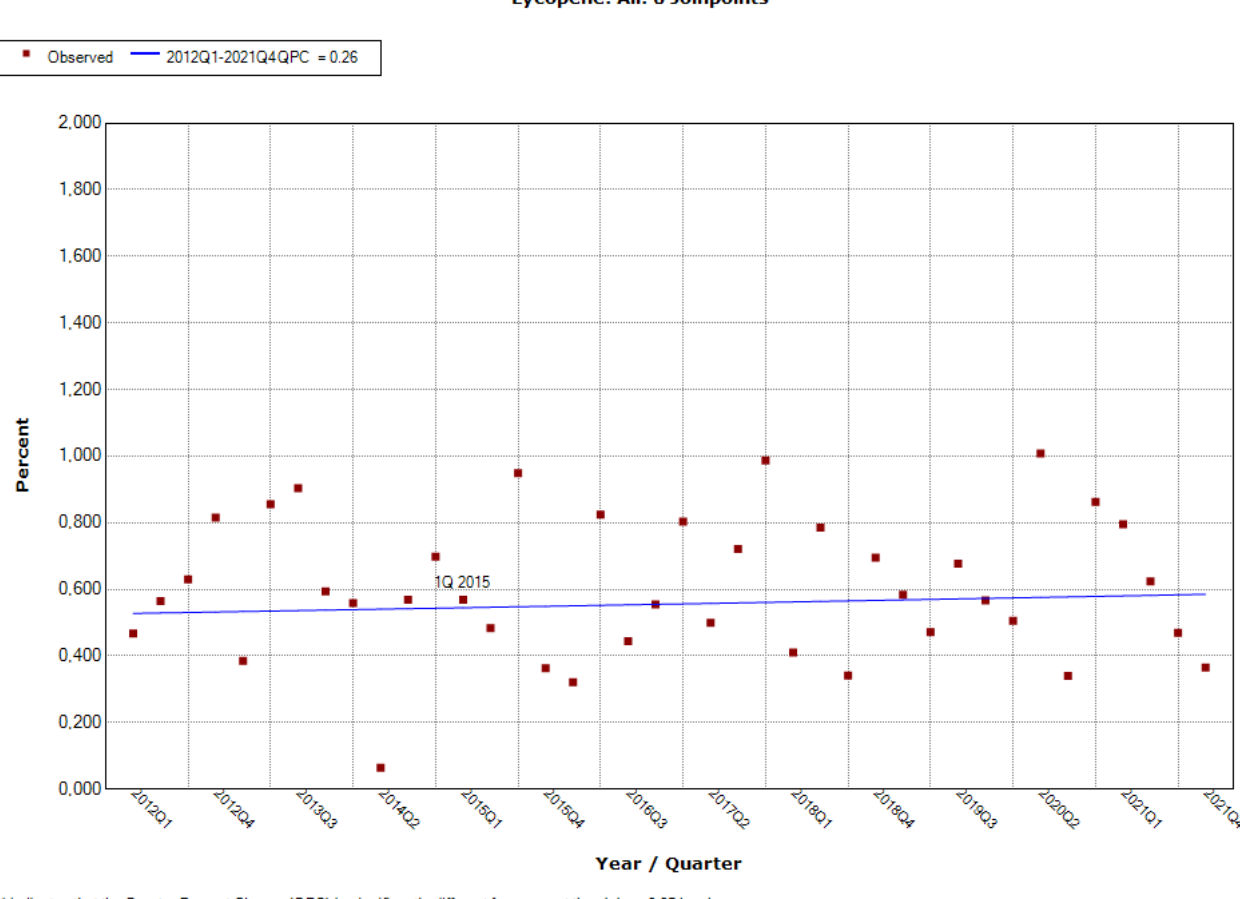
Figure A4. Percentage of products containing lycopene in individual quarters in the period from 2012 to 28 November 2021. Joinpoints mark trend turning points. The date above the observation indicates the moment of publication of the scientific opinion/resolution.